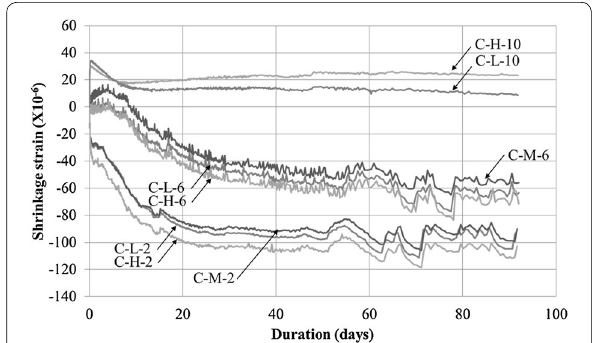
Fig. 17 Moduli of elasticity of all concrete samples at 28 days of curing.